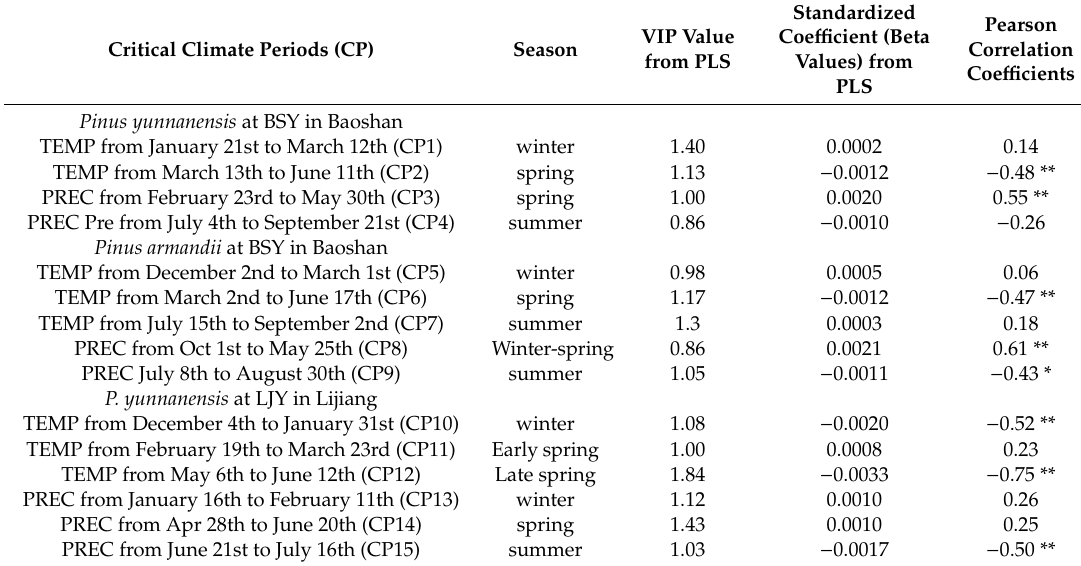
Table 2. Critical climate period (CP) for pine growth in Yunnan, southwest China indicated by standardized coe ffi cients from Partial Least Square (PLS) regression models and as well as Pearson the correlation coe ffi cients between CP and tree-ring widths for pine trees in Baoshan and Lijiang, Yunnan.